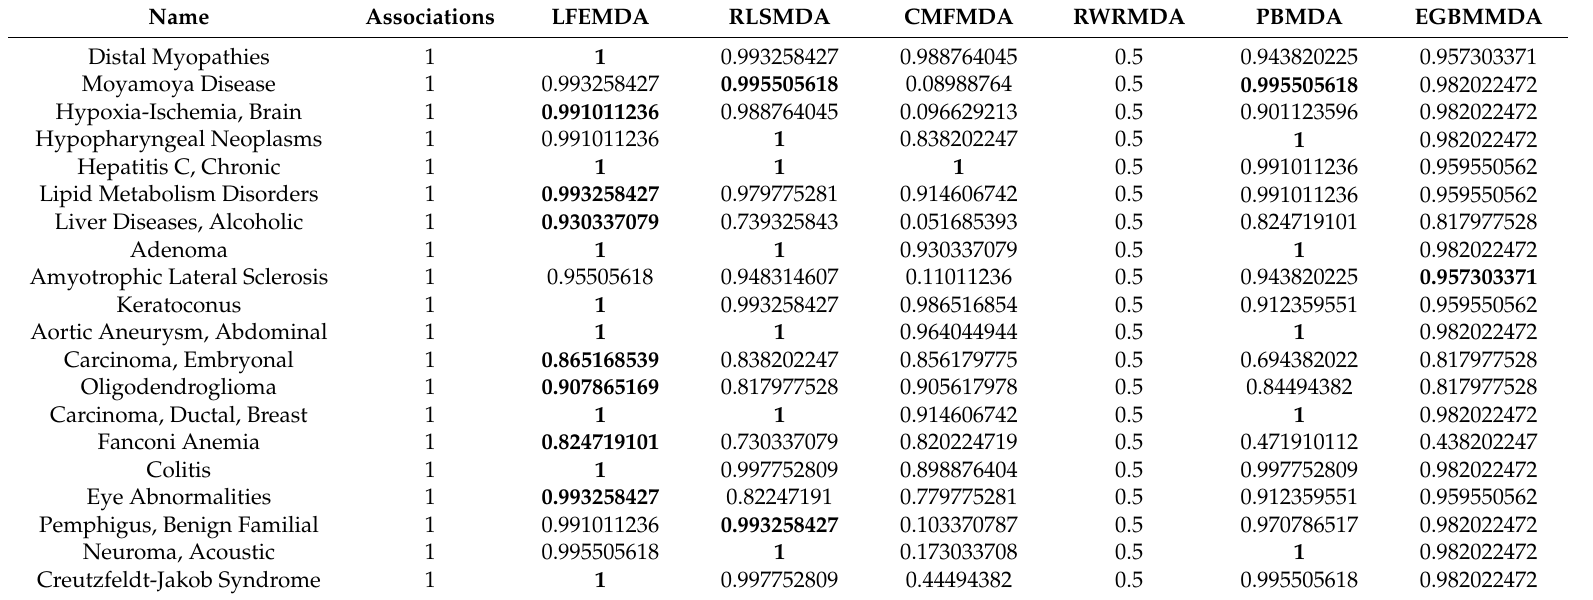
Table 2. The AUC results for new diseases under different